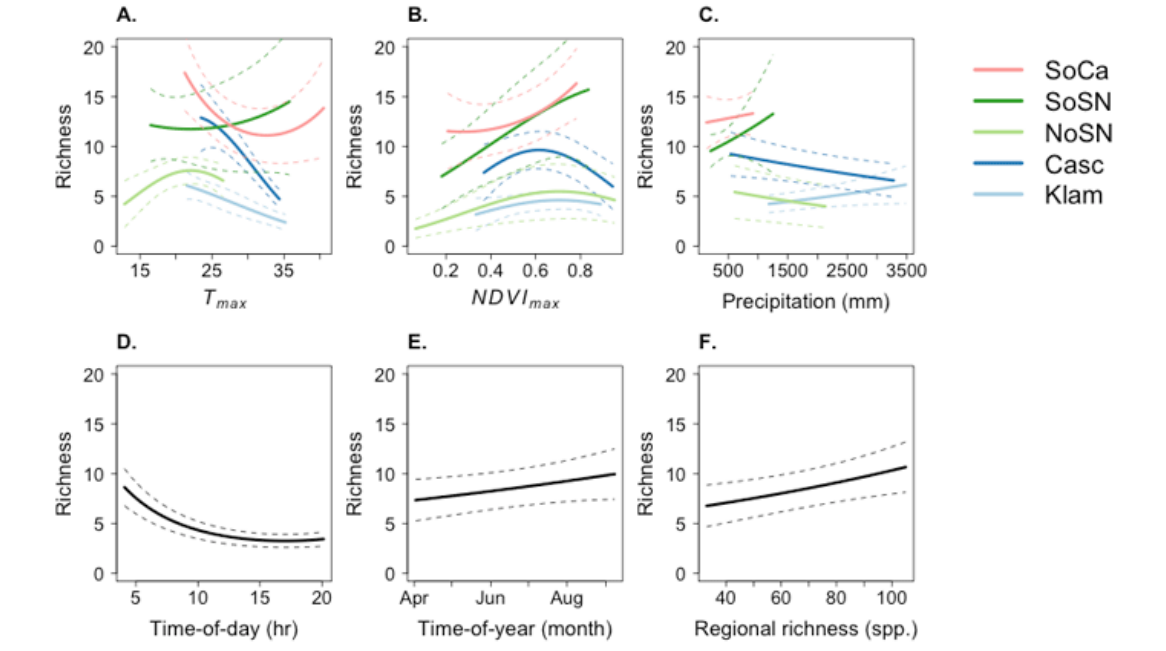
Fig. 2 . Modeled relationship and effect size of environmental (A-C) and sampling (D-F) factors associated with observed avian richness at point counts across each sampled region along the Pacific-Crest Trail. Relationships derived from each region’s best supported Generalized Linear Models (GLM) and show parameter means while controlling for mean conditions of all other covariates. SoCa: southern California mountains, SoSN: southern Sierra Nevada, NoSN: northern Sierra Nevada, Casc: southern Cascade Range, and Klam: Klamath Mountains.